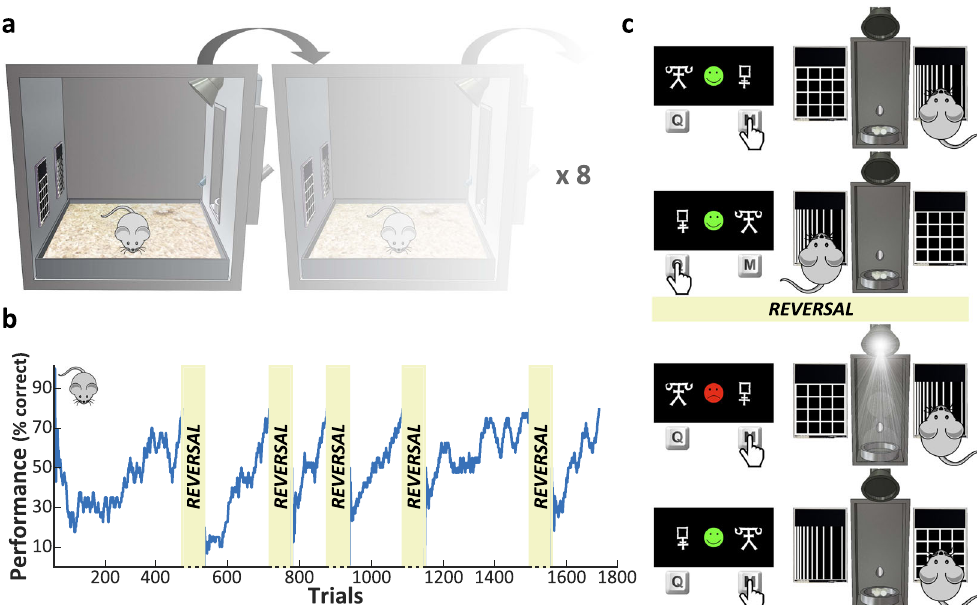
Fig. 1 Experimental design and apparatus of the reversal learning task. a Illustration of the behavioral apparatus. Up to 8 operant conditioning chambers run in parallel with mice living and working with minimal human intervention. Each operant chambers was equipped with capacitive touch-sensitive screens (left), pellet and water dispenser (right), and LED lights (top). b Example of one WT mouse performance (smoothed over a 40-trial sliding window) across fi ve reversals. c Design of the human (left) and the mouse (right) versions of the reversal learning task. On each trial, the subject had to make a choice between two different stimuli displayed on the screens. Depending on their choice, positive (for correct response) or negative (for incorrect response) feedback was provided. When the subject had learned the correct association, the reward contingencies were reversed without notice (see “ Methods ” section for